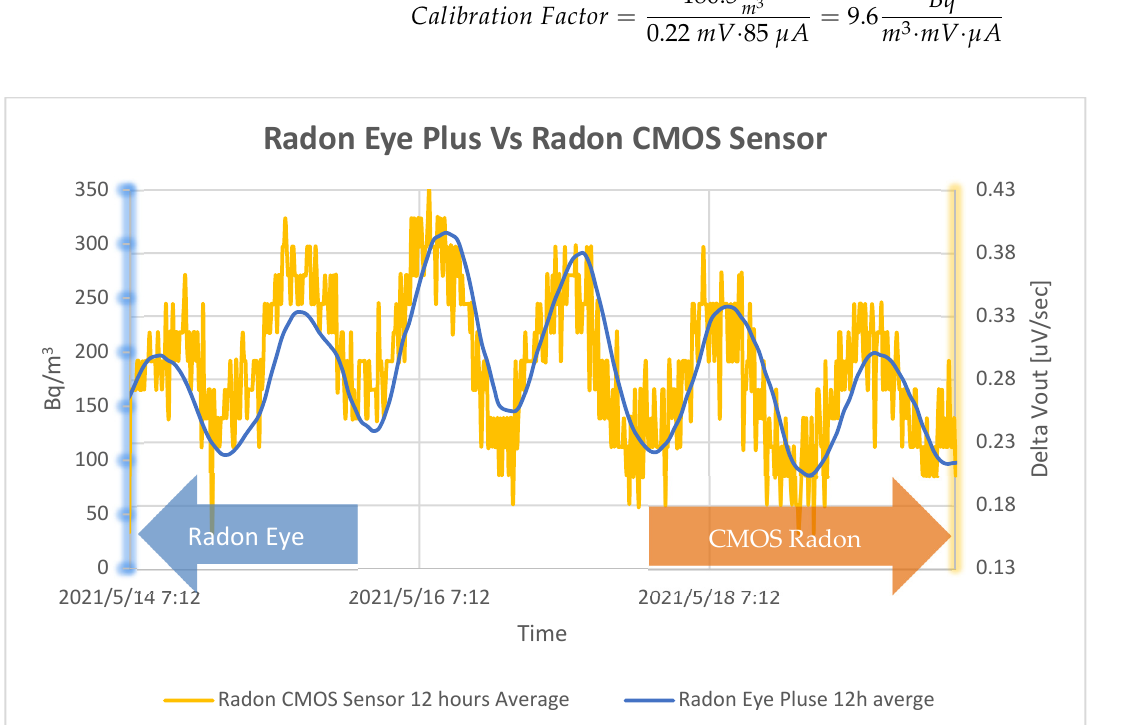
Figure 13. CMOS Sensor comparison to commercial detectors.